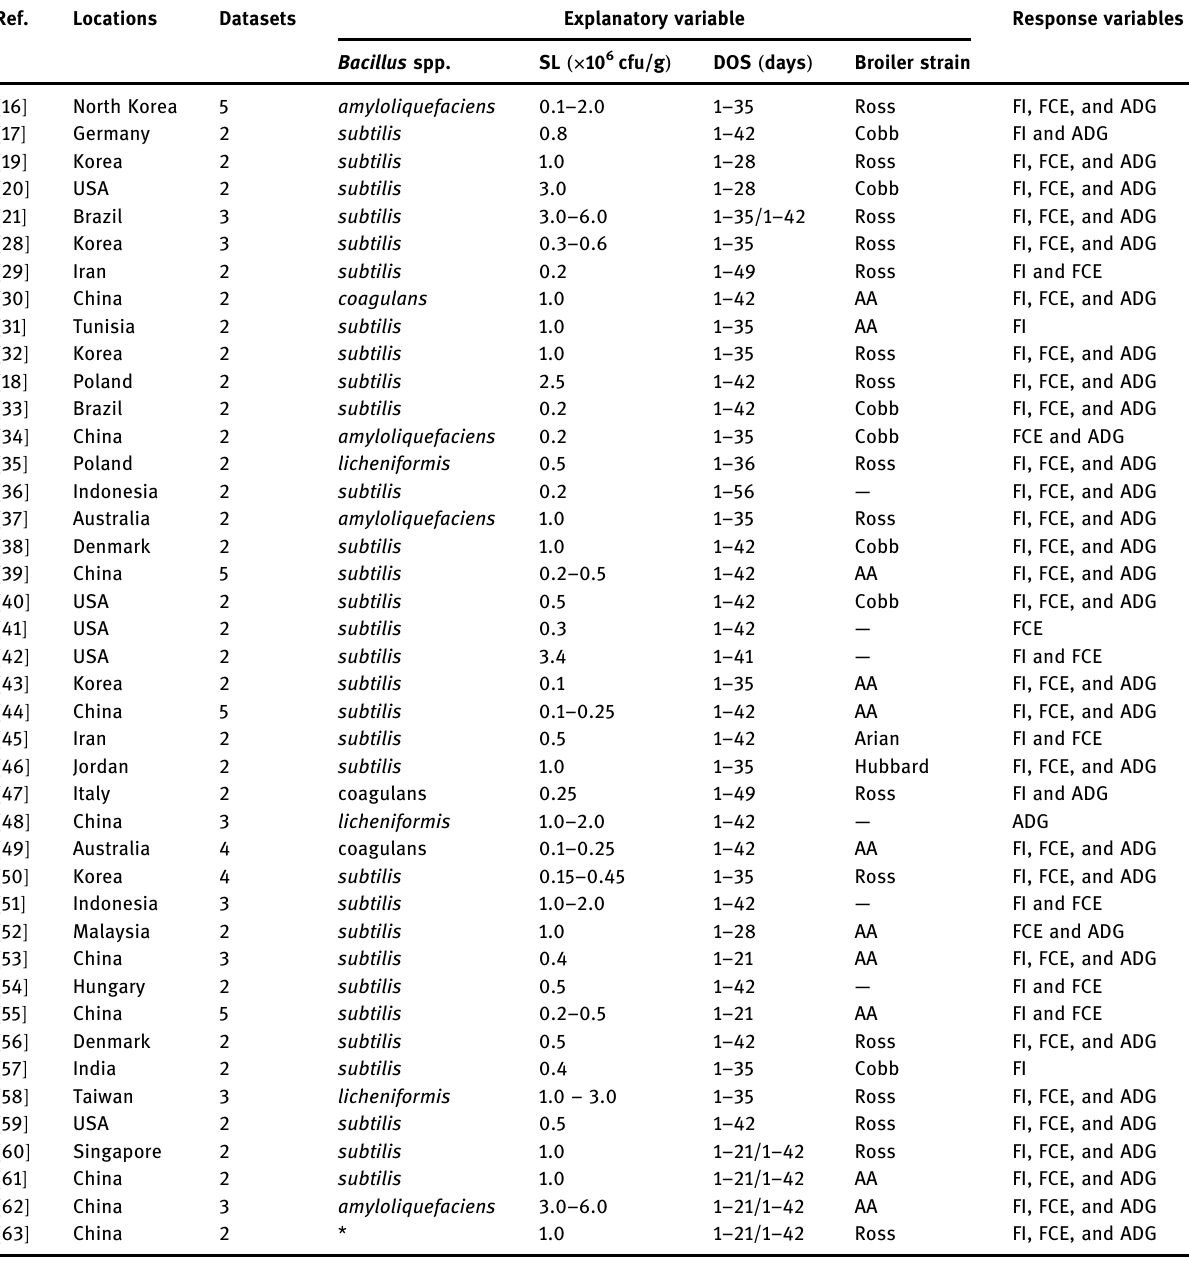
Table 1: Characteristics of studies included in the meta - analysis of e ff ect of dietary Bacillus supplementation in broiler chickens